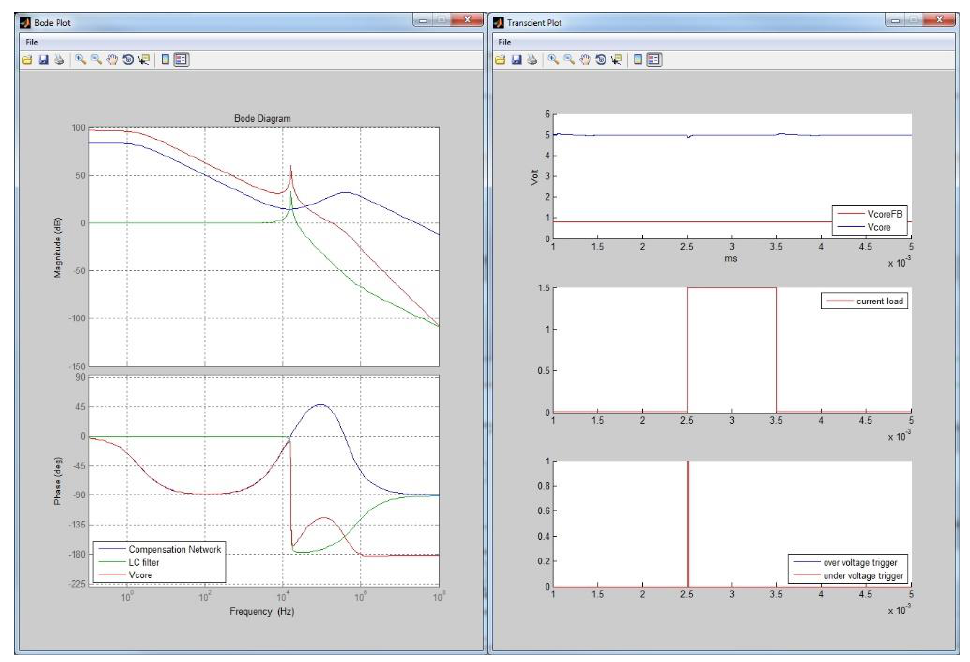
Figure 7. Buck converter stability in transient and Bode plots.